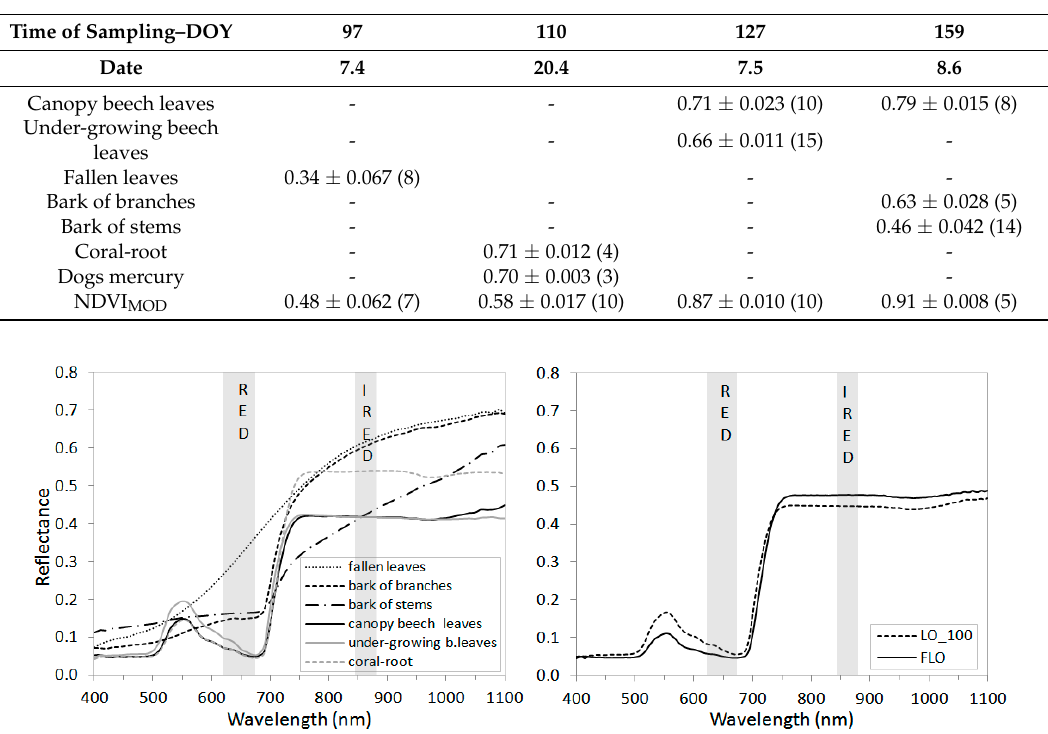
Figure 3. Spectral reflectance of all beech forest components measured with a Li 1800 integration sphere ( a ) and beech leaves from the phenological phases LO_100 (end of leaf onset) and final leaf onset (FLO) ( b ). The grey columns marked RED and IRED highlight the wavelengths used in the NDVI LAB calculations.